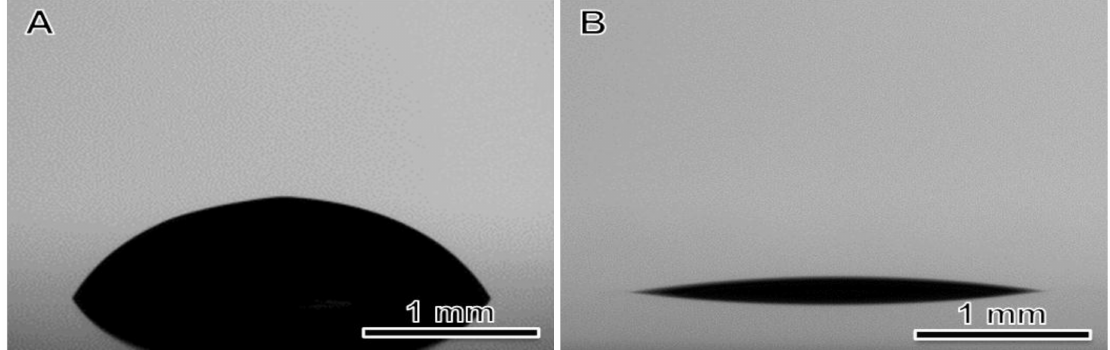
Figure 3. Contact angles for GO-SWNT ink on PET substrate: ( A ) before and ( B ) after plasma treatment. The contact angle is 59.7 ◦ and 10.2 ◦ ,